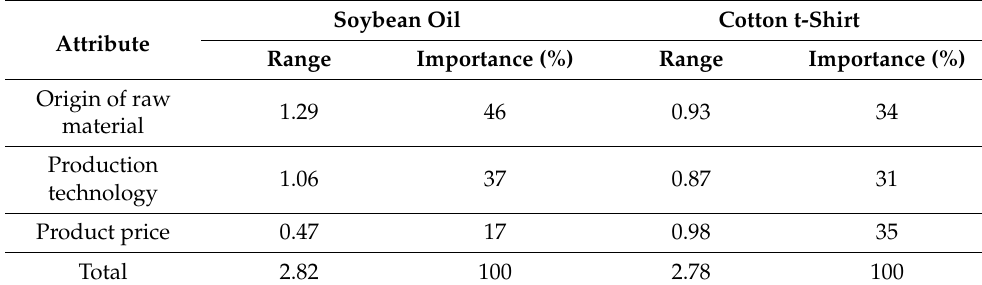
Table 7. A relative importance by an